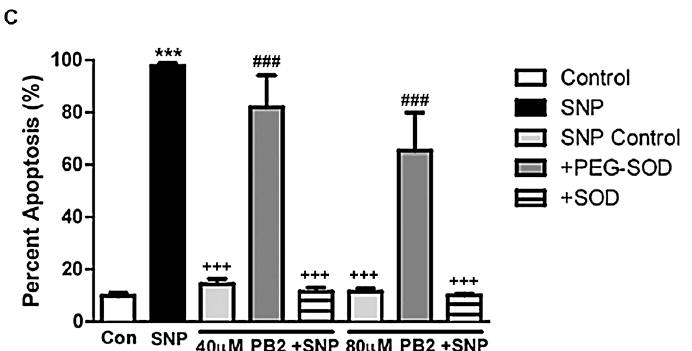
Figure 8. PEG-SOD, but not unconjugated SOD, prevents neuronal protection by PB2 in the presence of SNP. ( A ) CGNs were treated for 24 h with 100 µ M SNP alone or following pretreatment with 80 µ M PB2 in the absence or presence of either 30 U/mL PEG-SOD or 30 U/mL unconjugated SOD, and untreated control cells. The images show black and white Hoechst staining of neuronal nuclei. Scale bar = 10 µ m. Arrows point to cells which were scored as apoptotic. ( B ) Bright field images of CGNs treated with SNP + PB2 and either unconjugated or PEG-conjugated SOD to illustrate neuronal process morphology. ( C ) Quantitative analysis of percentage apoptosis of CGNs in untreated controls and cells treated with 100 µ M SNP alone or in combination with 40 µ M or 80 µ M PB2 with or without 30 U/mL PEG-SOD or unconjugated SOD for 24 h. Total cells and apoptotic cells were quantified and used to calculate percent apoptosis. Condensed or fragmented nuclei were considered to be apoptotic. Data are expressed as the mean ± SEM, n = 3. Data were analyzed by one-way ANOVA with a post hoc Tukey’s test. *** indicates p < 0.001 compared to untreated control. +++ indicates p < 0.001 compared to cells treated with only SNP. ### indicates p < 0.001 compared to cells treated with SNP and PB2.